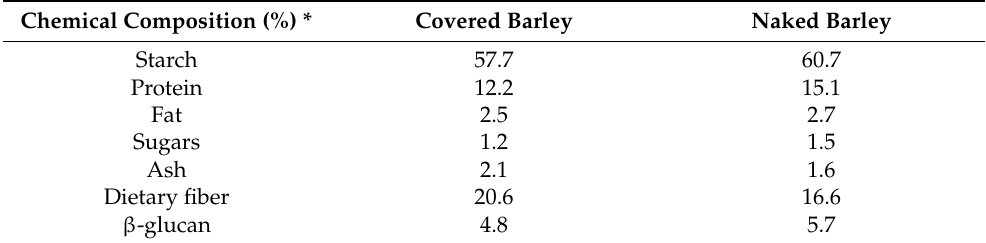
Table 2. Chemical composition of covered and naked barley grain [20]. Chemical Composition (%)